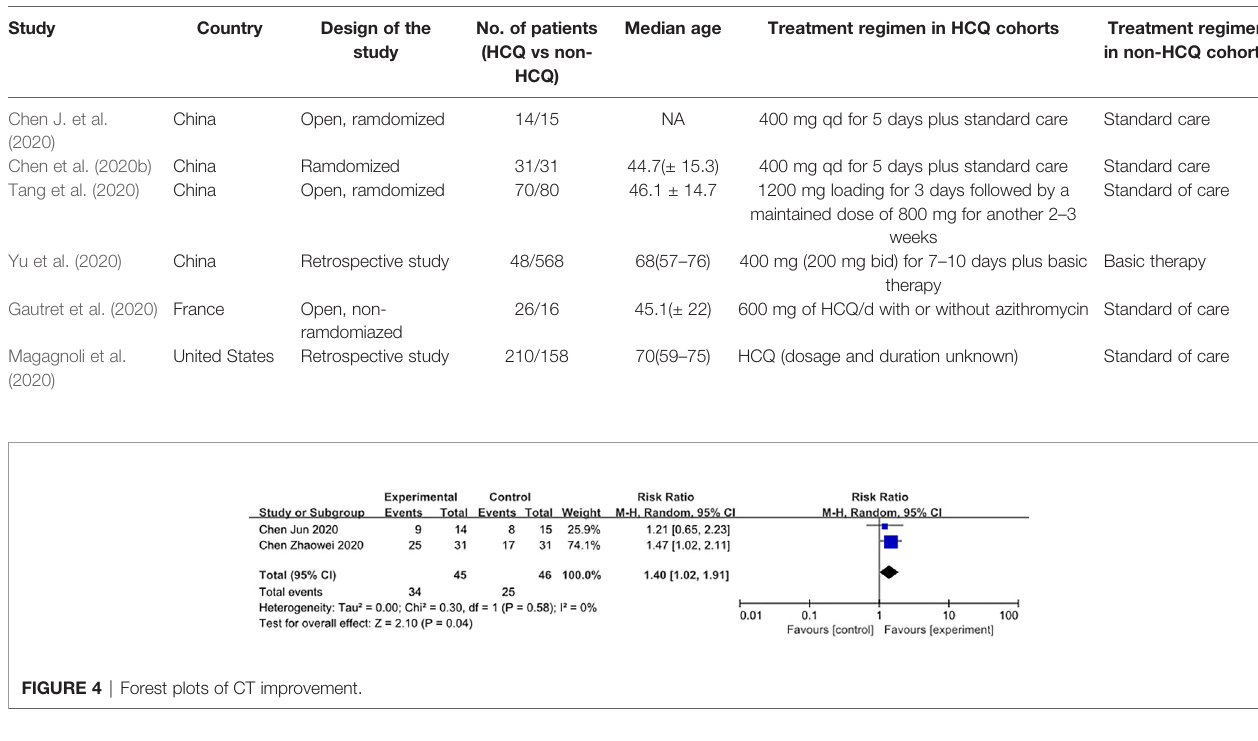
TABLE 2 | Characteristics of studies included in the meta-analysis.